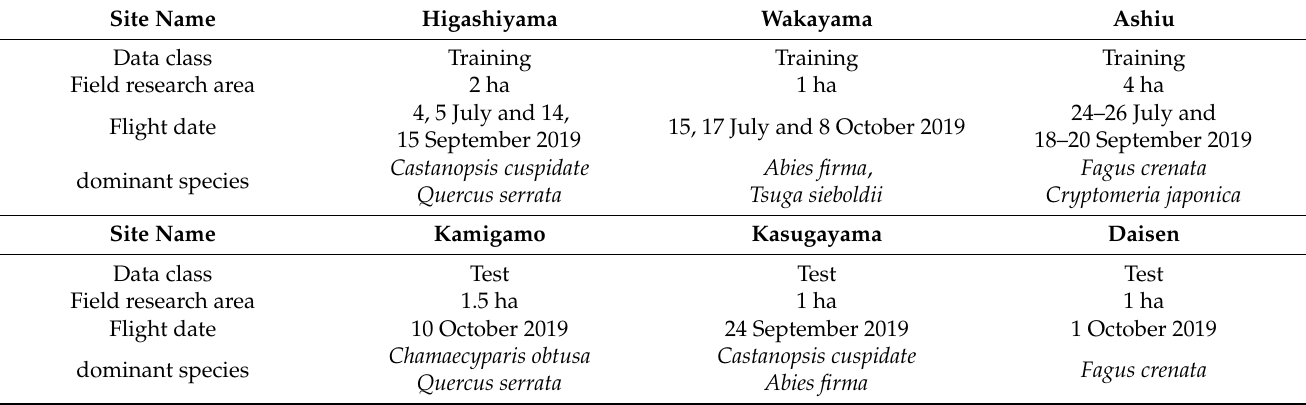
Figure 1. Location of each site. Green and orange points represent the training and test sites, respectively. Table 1. Site information